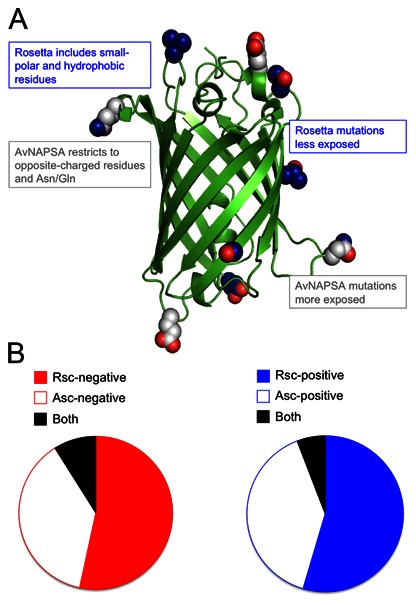
Rosetta and AvNAPSA supercharge protocols mutate different residues.
A) AvNAPSA-mutated residue positions (white) are highly exposed and are often in loop regions, while Rosetta-mutated residue positions (blue) are less exposed and two mutations are in stable secondary structures. Native side chains of the mutated positions are shown in spheres to convey that Rosetta can mutate hydrophobic and small-polar residues. We emphasize that no mutations are shared between the two approaches in this low-charge design. B) Moderate supercharging was performed on 600 monomeric proteins, and the mutated residues were compared – each monomer was designed with the same net charge in both approaches. Rosetta requires more mutations to achieve the same net charge (solid v. empty). For negative-charge designs, 9% of mutated residue positions are shared (black, left). For positive-charge designs, 6% of mutated residue positions are shared (black, right). Shared mutations decrease an additional ∼2-fold considering that the chosen residue type differs ∼50% of the time for the shared residue positions – AvNAPSA never uses arginine, and AvNAPSA only uses aspartate if the native residue is asparagine.